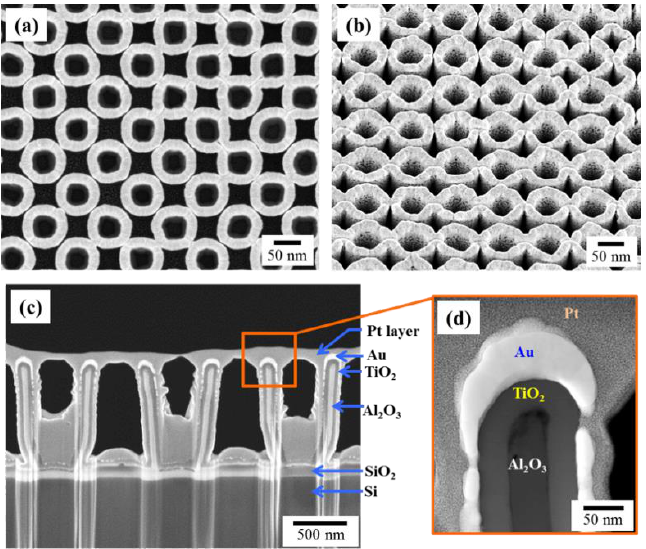
Figure 12. ( a ) A top view SEM image of the fabricated cup-like water splitting nanostructures. ( b ) Tilted SEM image of the sample. ( c ) Cross-sectional view of a thin slice of the nanostructures prepared using FIB deposition and milling, showing the structure and different layers. ( d ) High magnification STEM image taken from the region indicated by the orange box in ( c ). Adapted from [86] with permission from the PCCP Owner Societies, 2017.